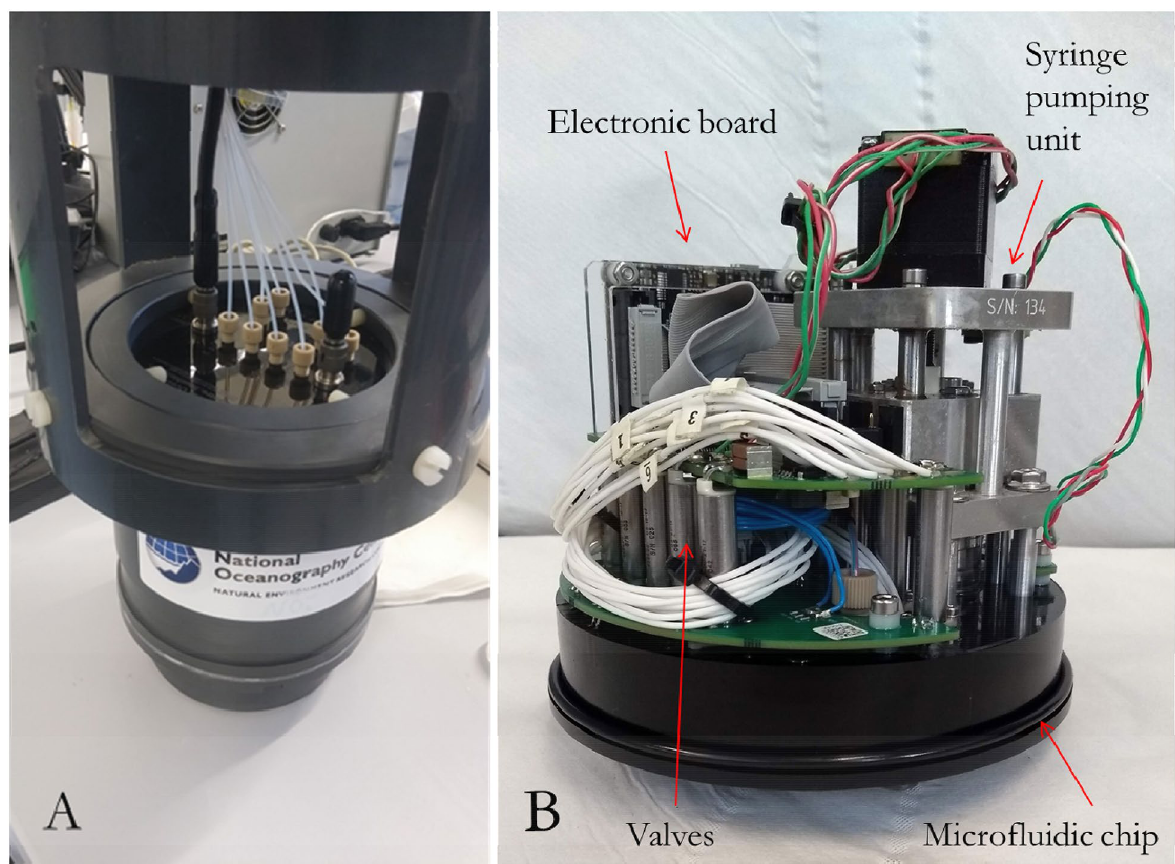
Figure 7. Hardware of second generation LoC analyser, ( A ) watertight PVC housing with microfluidic chip and fluid connectors, ( B ) microfluidic PMMA chip (119 mm in diameter) mechanical and electronic package (note the different orientation when mounted in PVC